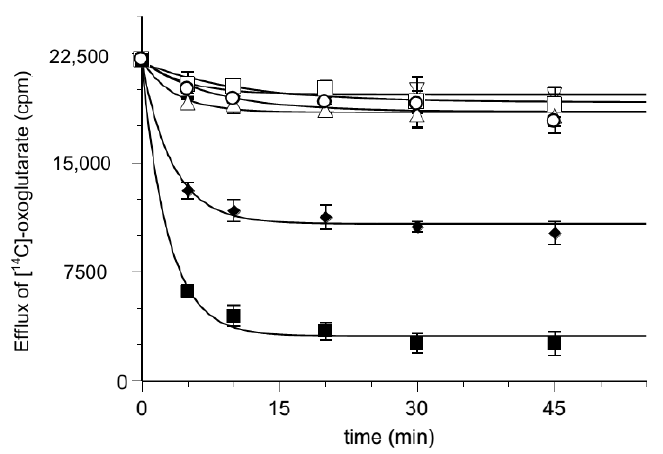
Figure 7. Effect of hemin on the time course of [ 14 C] 2-oxoglutarate efflux from proteoliposomes. Efflux of [ 14 C] 2-oxoglutarate from pre-labeled proteoliposomes with radioactive substrates was measured as described in Materials and Methods in the presence of external 50 mM NaCl and 10 mM Pipes pH 7 buffer ( (cid:53) ), DMSO solvent ( (cid:52) ), 0.025 mM 2-oxoglutarate ( (cid:7) ), 0.25 mM 2-oxoglutarate ( (cid:4) ), 0.010 mM hemin ( (cid:3) ) and 0.010 mM hemin with 0.025 mM 2-oxoglutarate ( ) added at time 0. The data are the means ± SD from three different experiments.